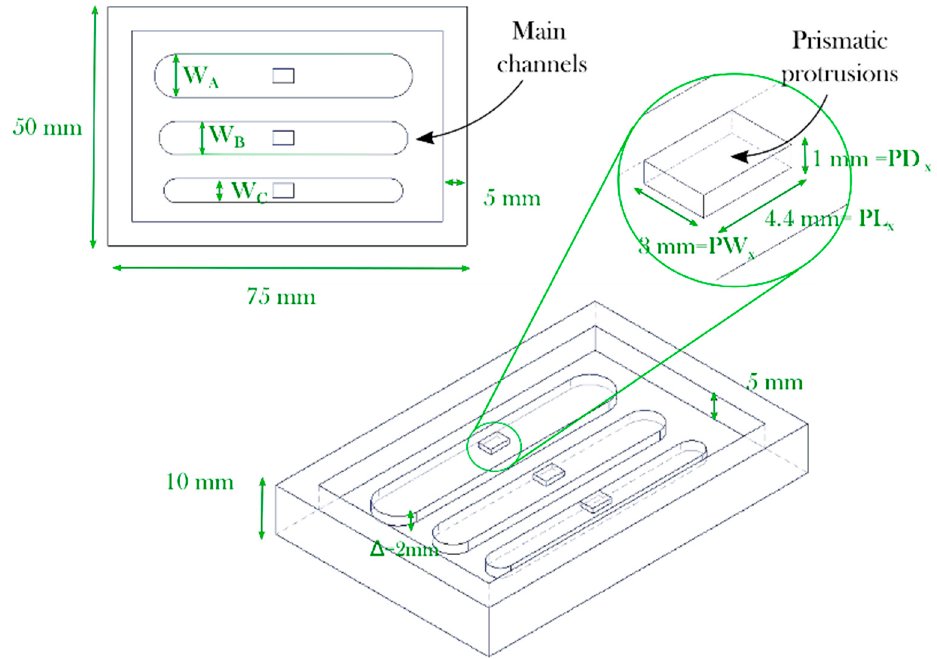
Figure 2. Soft tooling design for photopolymers and process screening.